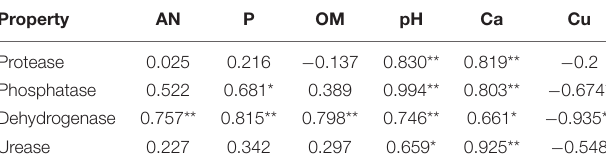
TABLE 1 | Correlation analysis of the soil physical and chemical